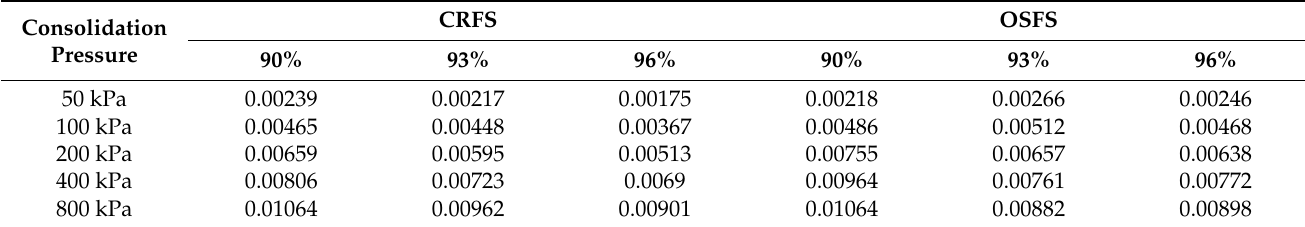
Table 5. Secondary consolidation coefficient of modified soil with different compaction degrees.